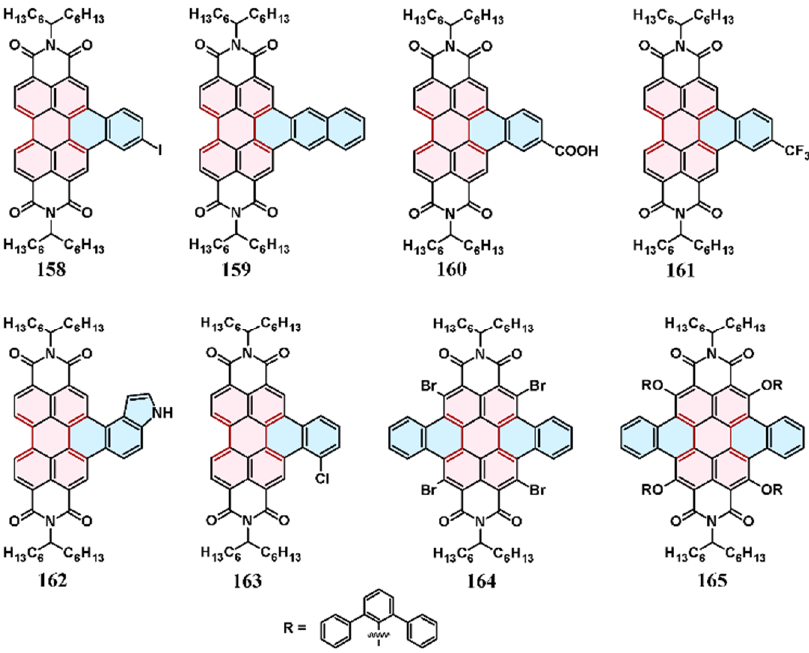
Figure 4. Core-expanded functionalized perylene bisimides (yields: 22–89%) [133].